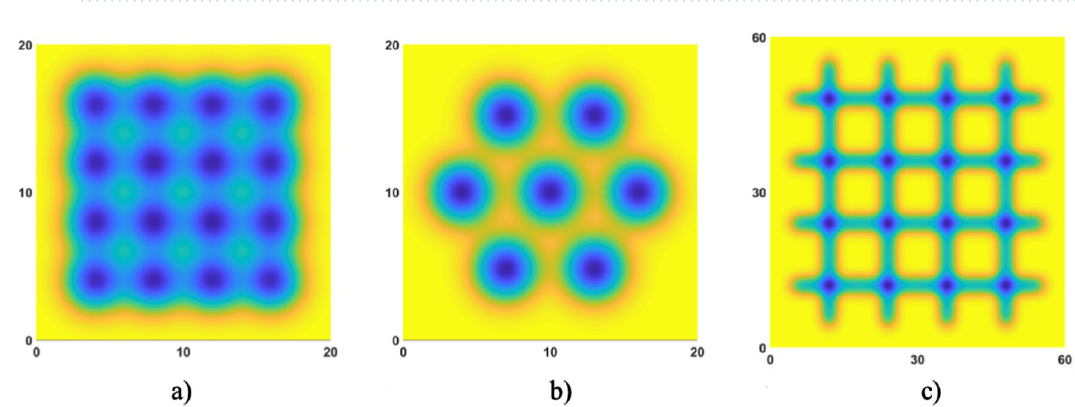
Figure 12. Schematic of discrete APPS of different 2D patterns.